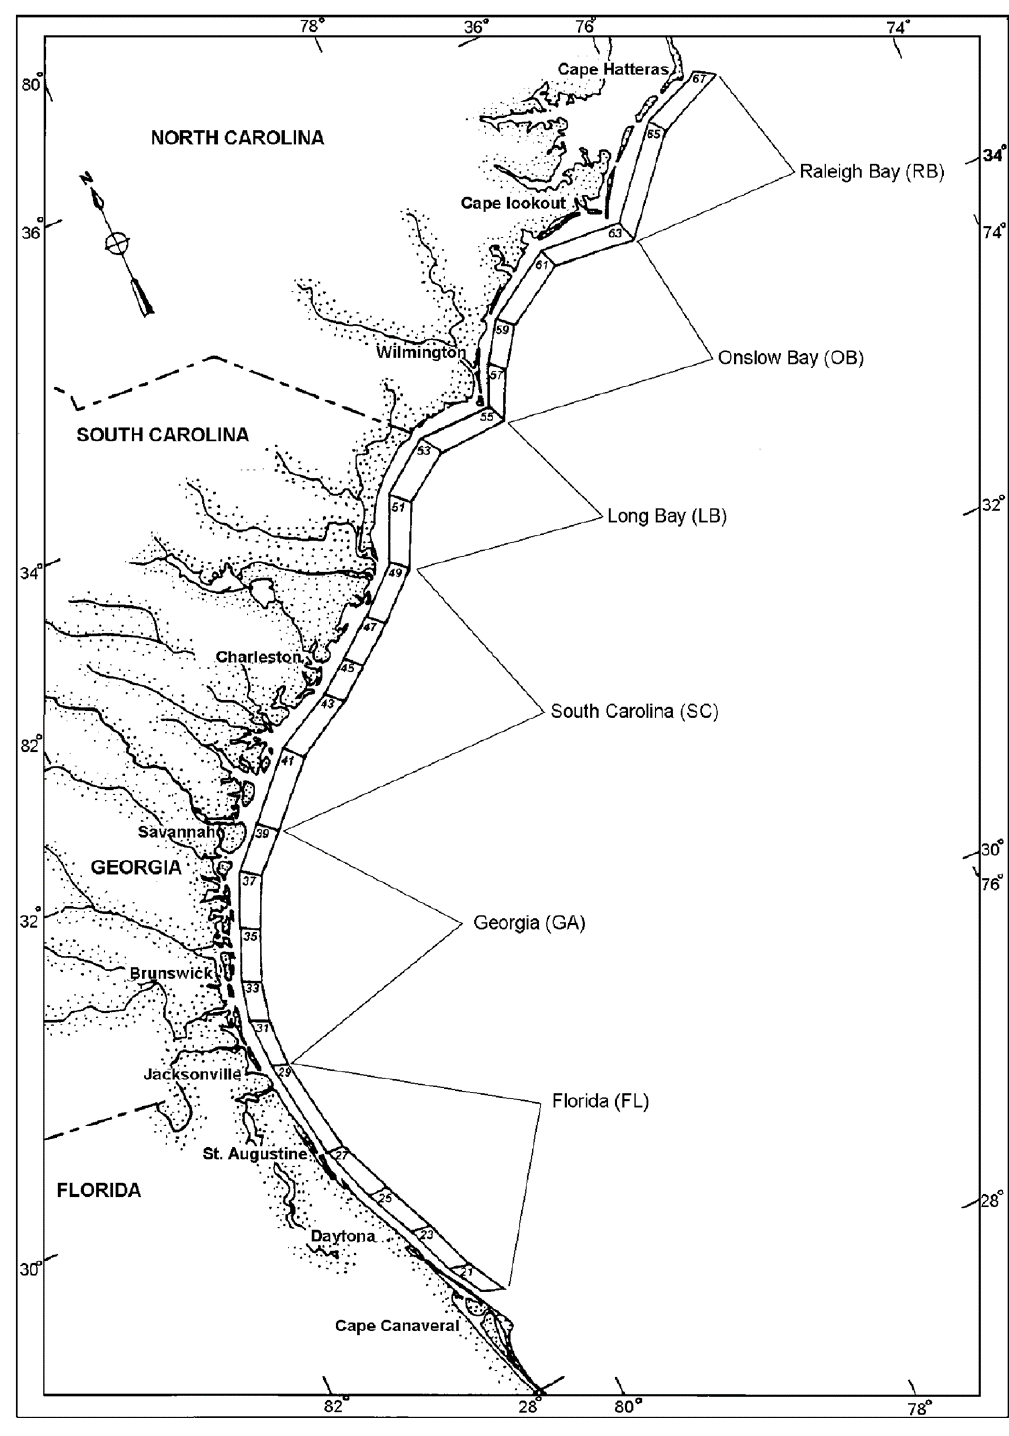
Figure 68. States and stations sampled as part of the SEAMAP trawl survey (map provided by SC DNR and